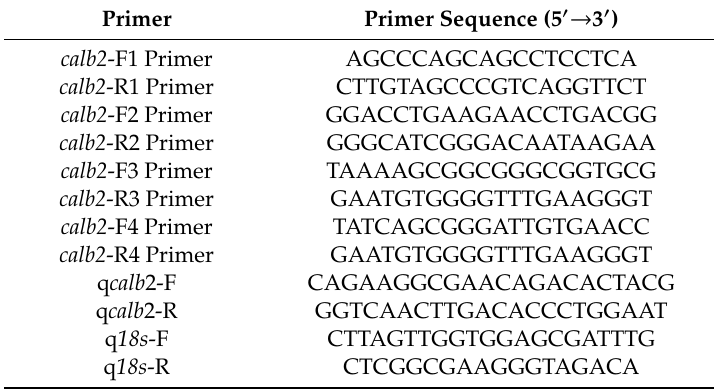
Table 1. The primer sequences for cloning and real-time quantitative PCR of calb 2. Primer Primer Sequence (5 (cid:48) → 3 (cid:48)